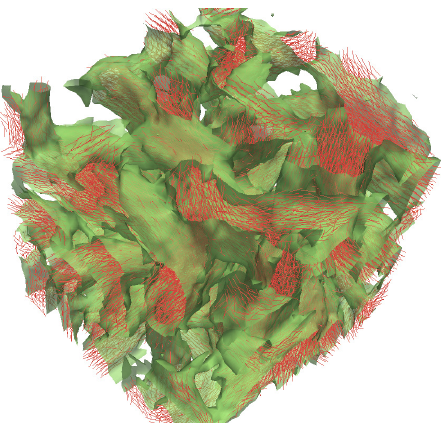
Figure 7. Iso-surface of the composition scalar parameter ψ ( r ) = 0 corresponding to the interface between the rigid and flexible domains (green surface). Red lines are the local nematic director ˆ n ( r ) where local ordering S ( r ) ≥ 0.7